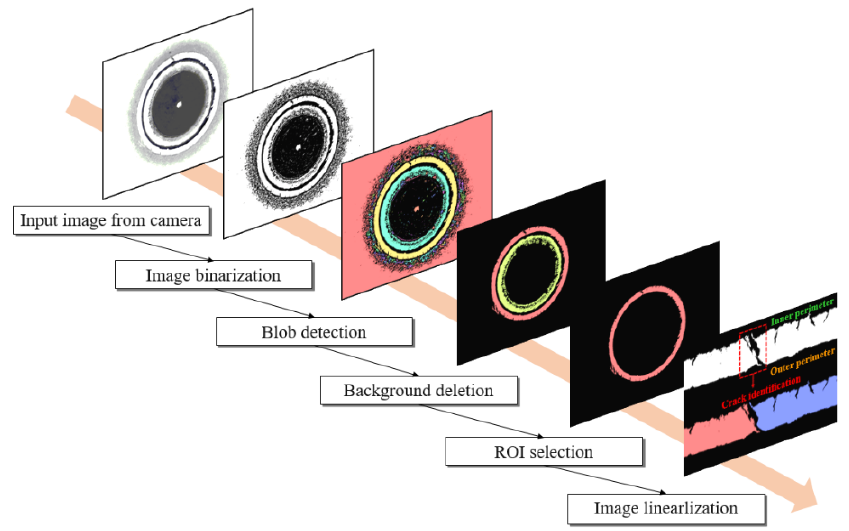
Figure 6. Image processing procedure for crack identification [16].